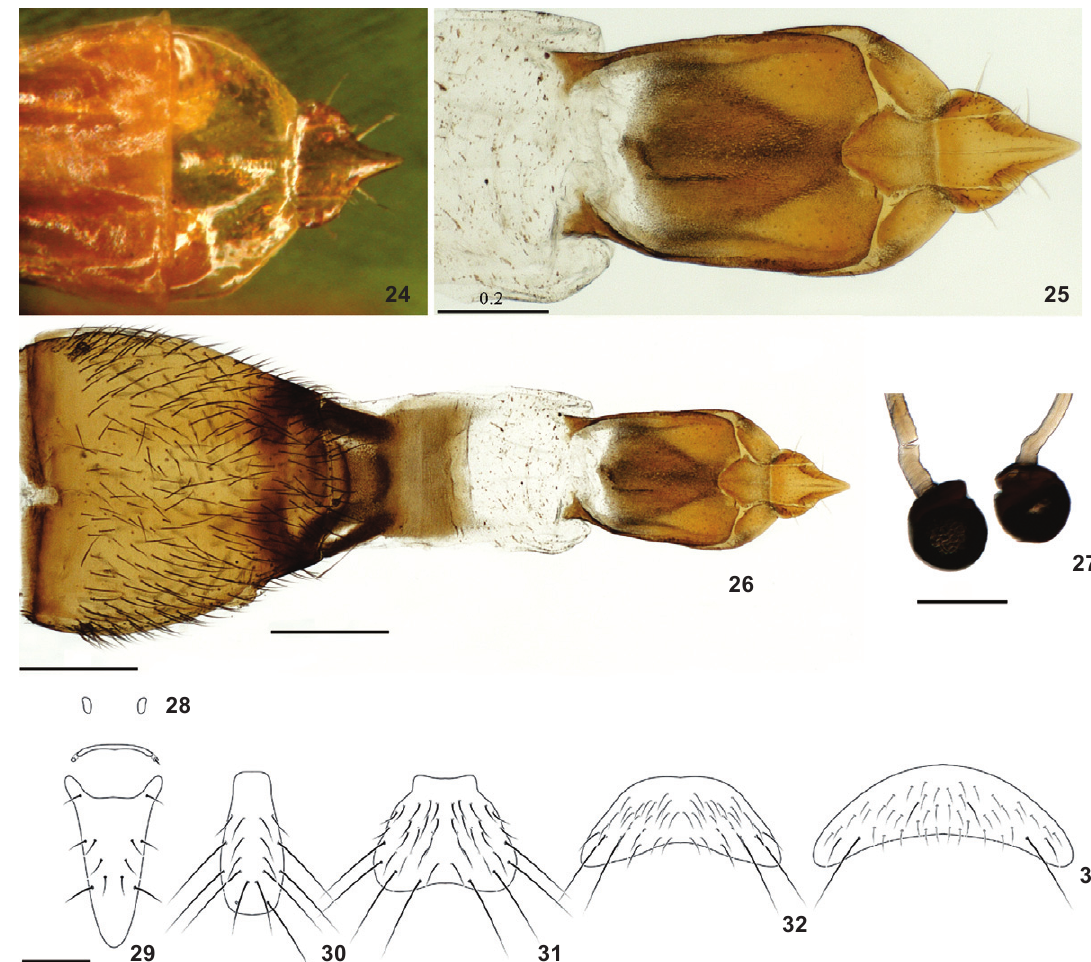
alula, base of cell br, base and sub-base of cell r ; cells bm and 1 cup, basal half of anal lobe, subtriangular or slightly oval me- dian area on cell cua (Fig. 4, indicated with black arrow), a 1 wide transverse and oblique median area from the costal mar- gin to cell dm, triangular preapical area from R to posterior 4+5 margin of wing (Fig. 4, indicated with red arrow); apical fourth completely brown, without hyaline areas (Fig. 4). Abdomen : yellow, with brown band on basal fourth of syntergite 1+2; covered with black setulae. Syntergite 1+2 1.5 times wider at apex than at base; 2.5 times longer than tergite 3. Tergites 3-5 gradually narrower than apex of syntergite 1+2. Sternites 1-6 yellow; sternite 1 present, but reduced into two very small sub- circular plates and weakly sclerotized (Fig. 28); sternite 2 di- vided into two portions: anterior very reduced and